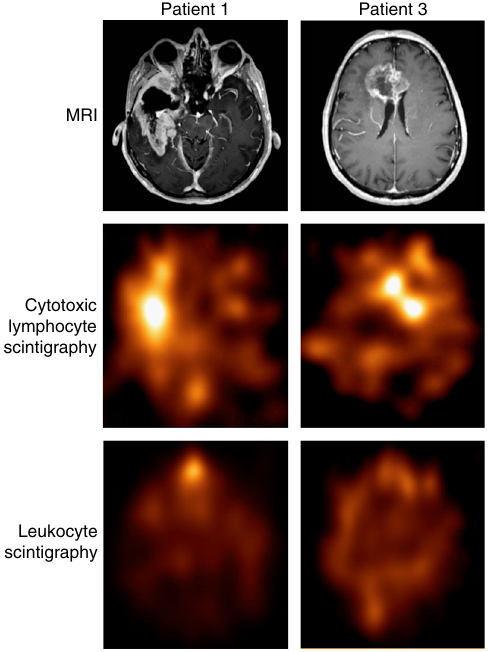
Fig. 4 Homing of cytotoxic lymphocytes to the tumor site. The brain tumors are depicted on the MRI (upper panel). Cytotoxic lymphocyte scintigraphy (second panel) shows true positive foci with 3.1 and 1.9 times higher uptake of radiolabeled cells in the brain tumor than in the contralateral